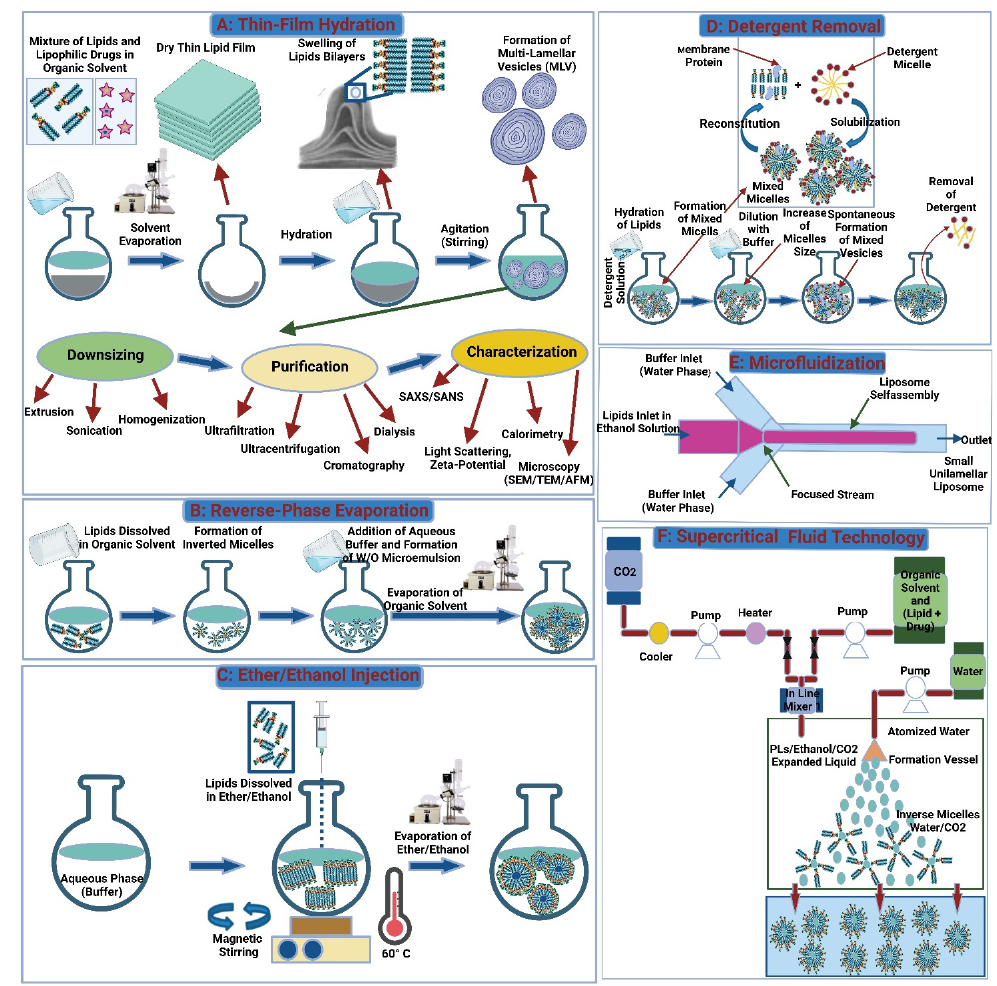
Figure 4. Schematic representation of the main methods of LPs preparation: ( A ) Thin-Film Hydration. ( B ) Reverse-Phase Evaporation. ( C ) Ether/Ethanol Injection. ( D ) Detergent Removal. ( E ) Microfluidization. ( F ) Supercritical Fluid Technology.